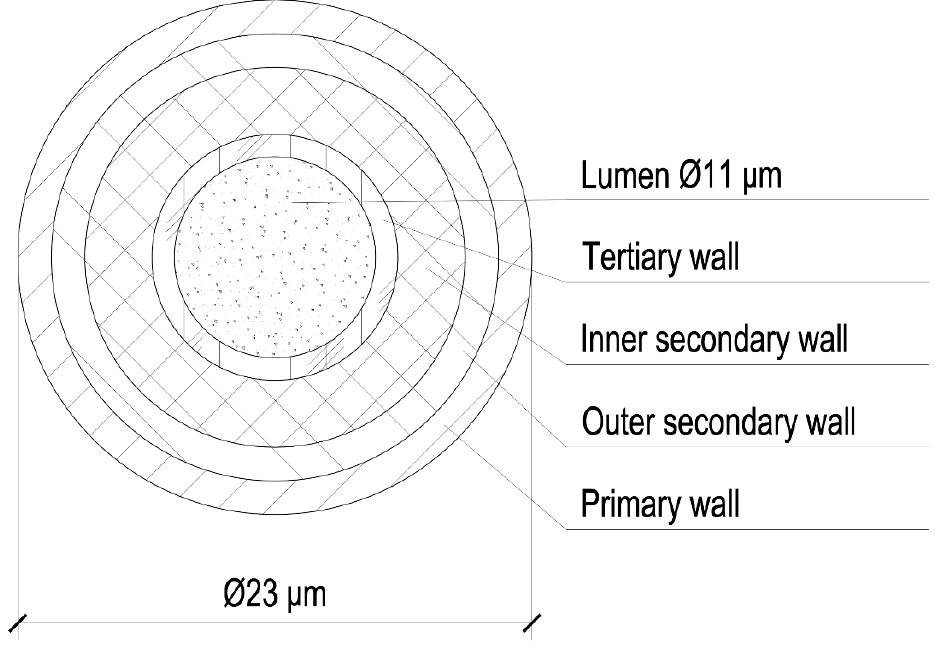
Figure 1. Sisal fiber structure.